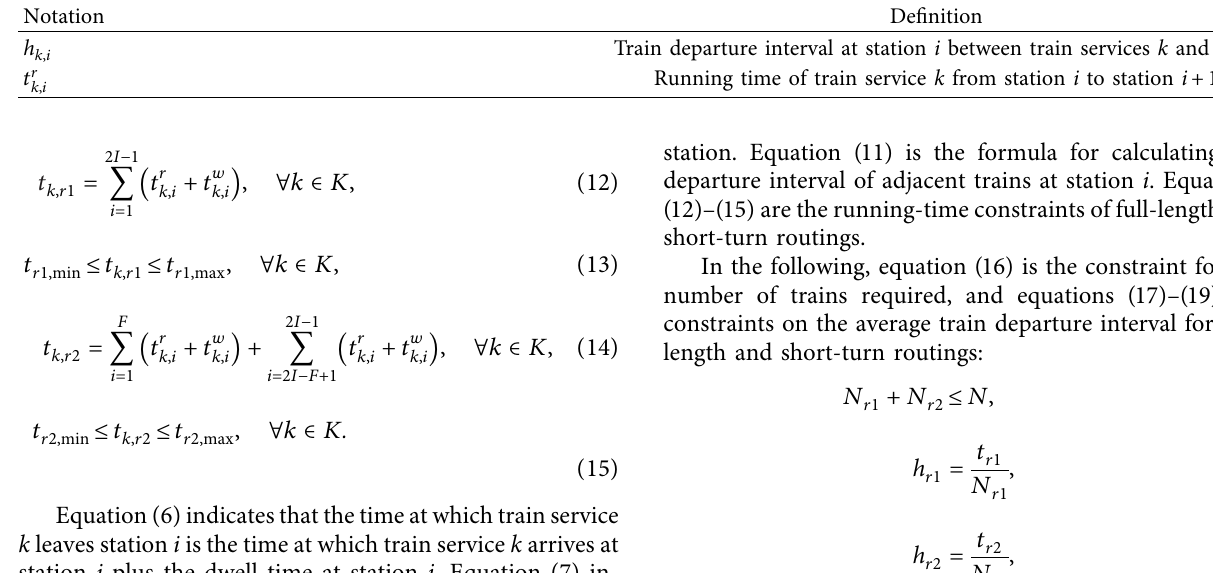
Table 2: Decision